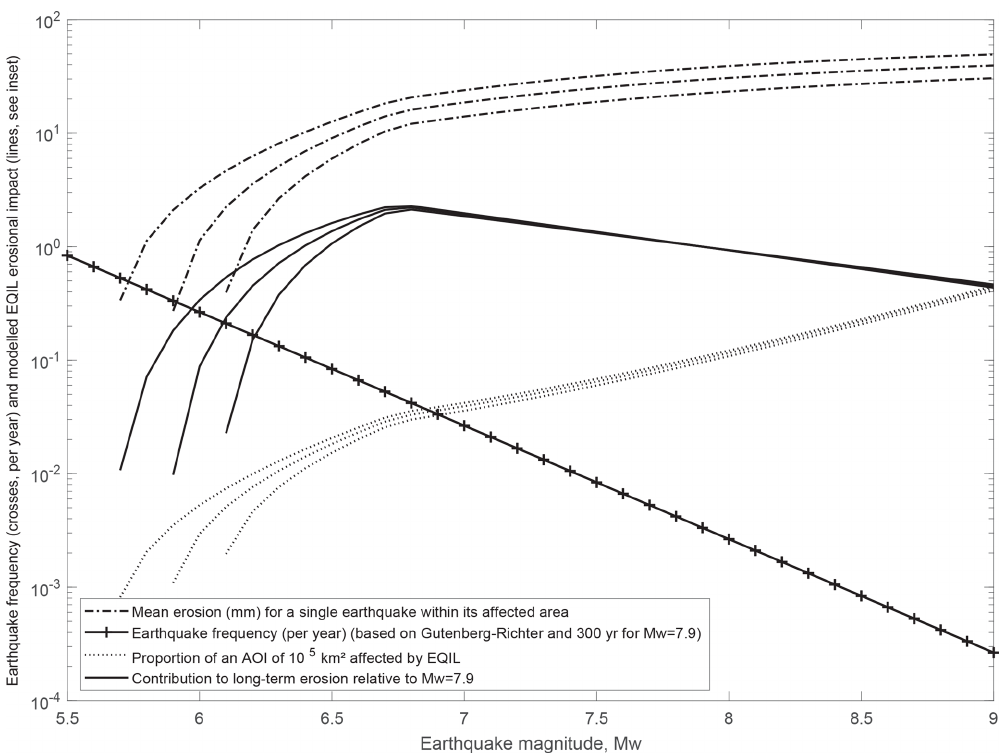
Figure 6. Mean landslide erosion (dash–dot line), earthquake contribution to long-term erosion relative to a M w 7.9 earthquake (solid line), earthquake frequency (crossed line) and earthquake-induced landslide distribution area normalized by a reference area (or area of interest, AOI) of 10 5 m 2 (dotted line), plotted against earthquake magnitude. For each variable the upper, middle and lower curves are for a seismic source depth of 10, 12.5 and 15km,